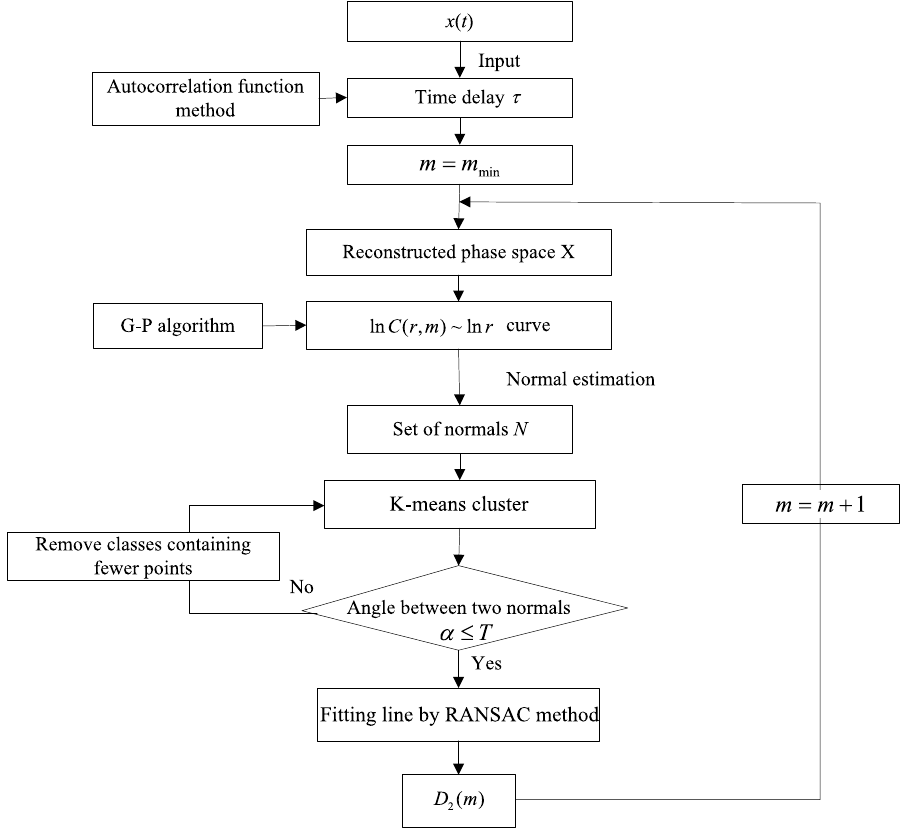
Figure 2. Flow chart of the proposed algorithm for computing correlation dimensions (the details are listed in the